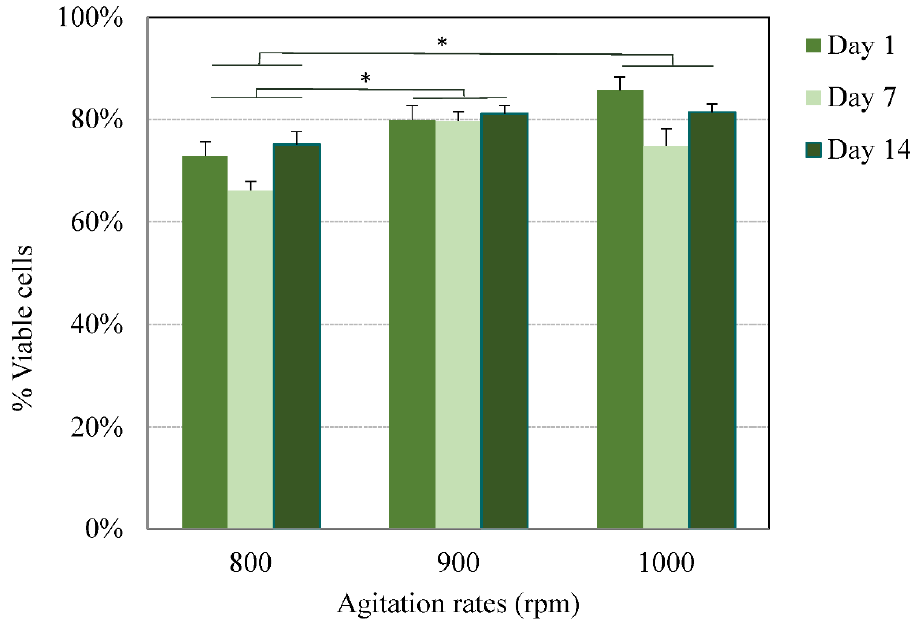
Figure 2. Viability of hBM-MSCs encapsulated in alginate beads prepared at various agitation rates. Cells were encapsulated in MVM alginate beads (2 × 10 6 cells/mL alginate) at agitation rates of 800, 900, and 1000 rpm and cultured for up to two weeks. Cells were recovered from the beads following degelling and counted using the Trypan blue exclusion method. For any agitation rate, no significant difference was noted in the viability between the different days ( p < 0.05, linear regression model). No statistical difference was noted in the average viability between 900 and 1000 rpm (* p < 0.01, Tukey test).